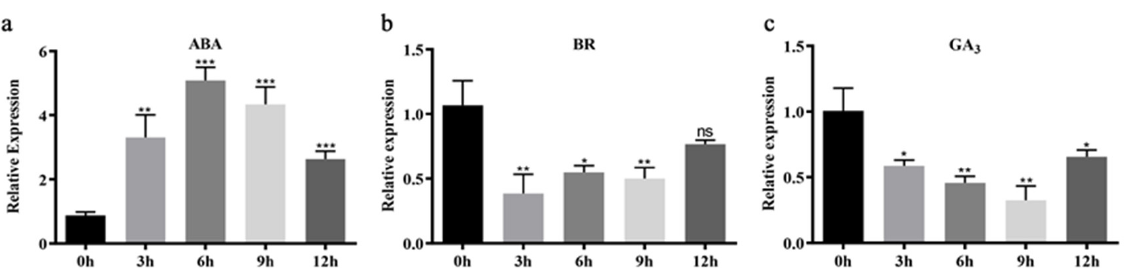
Figure 8. The expression of MdCoL in columnar apple ‘Wijcik McIntosh’ under different hormones treatments. The expression levels were detected in ‘Wijcik McIntosh’ seedlings at 0, 3, 6, 9 and 12 h after treatment with 200 μM ABA ( a ), 200 μM BR ( b ) and 500 μM GA 3 ( c ). Error bars show standard deviation from three independent biological replicates (* p < 0.05; ** p < 0.01; *** p < 0.001; “ns” means no significant difference).